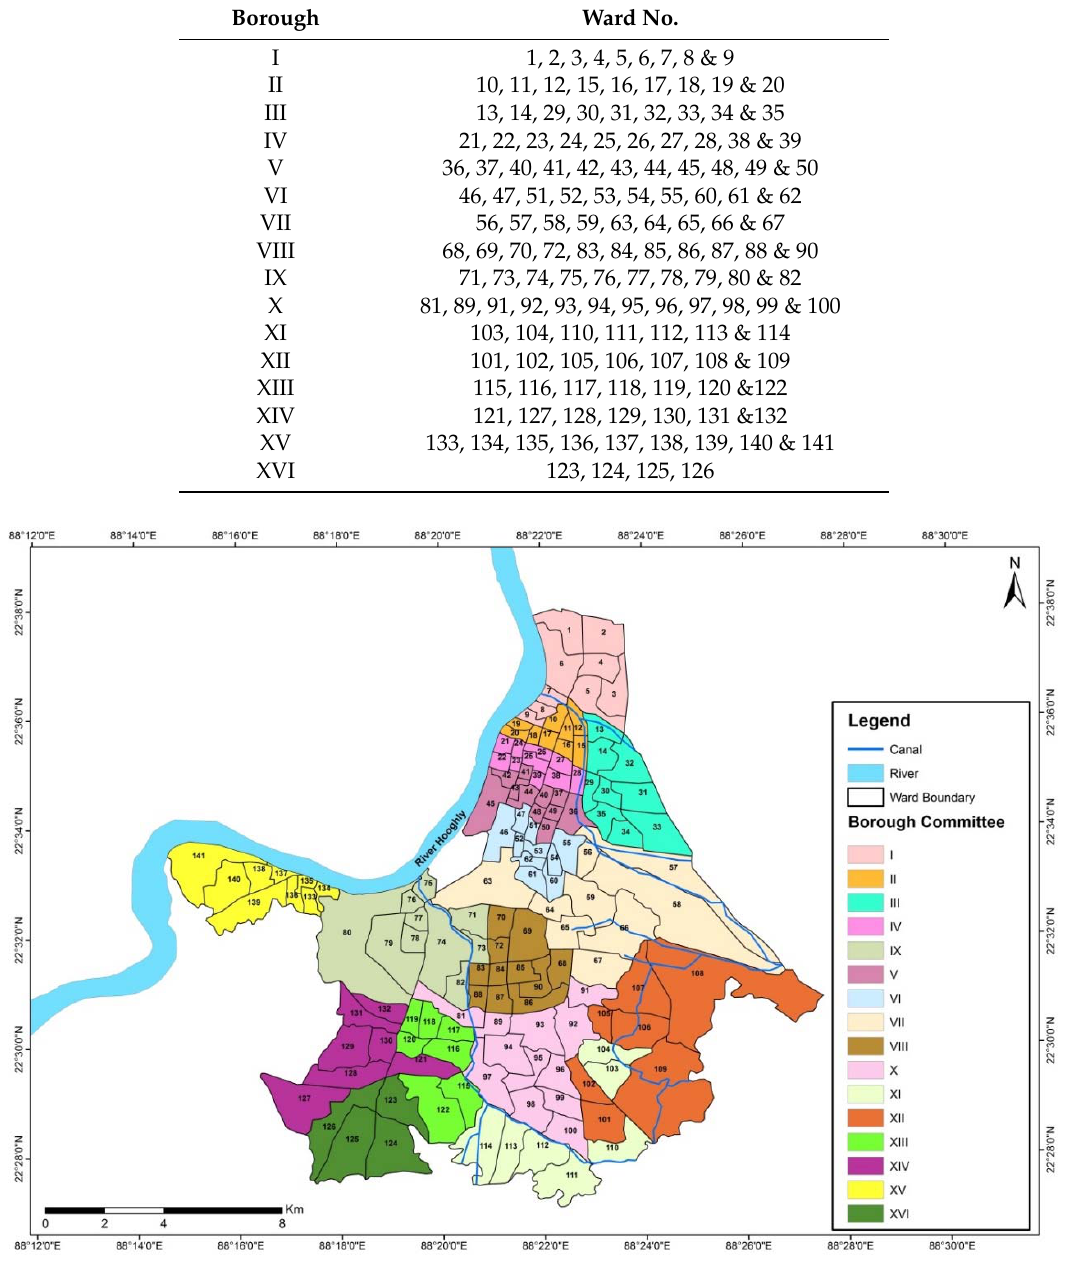
Table 1. List of Boroughs and the associated wards of the Kolkata Municipal Corporation (KMC); (excluding the newly added three wards until 2016 annual report published by KMC; Kolkata Municipal Corporation, 2016).